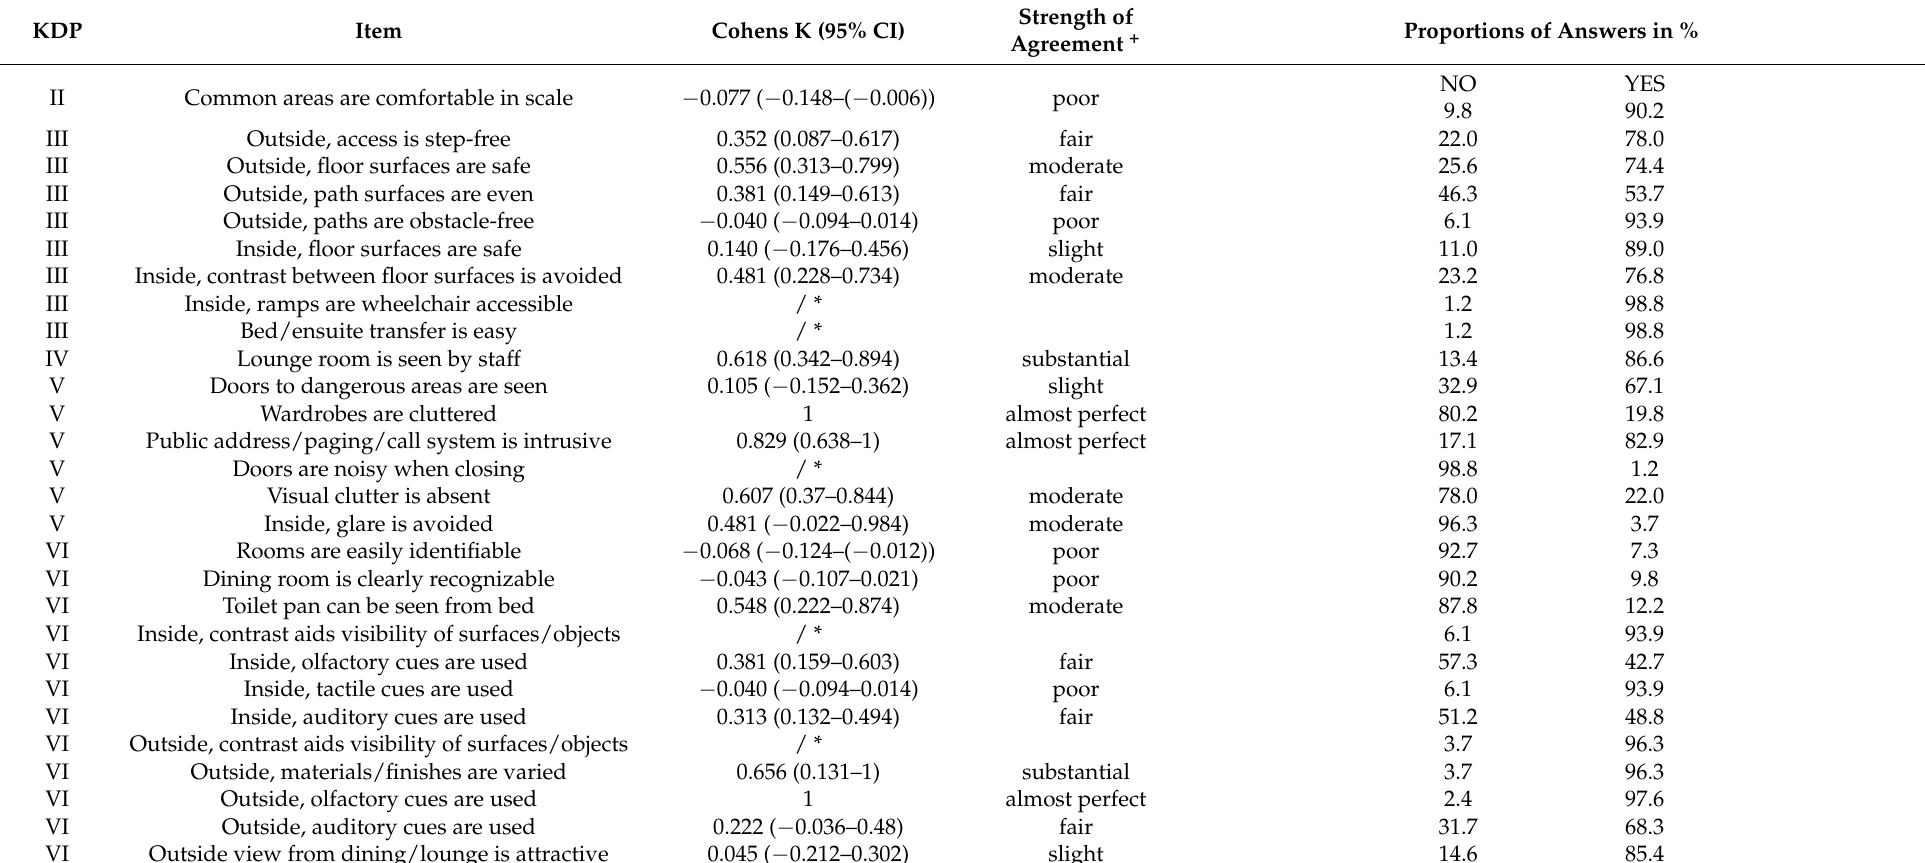
Table 1. Cohen’s Kappa and proportions of answers on G-EAT